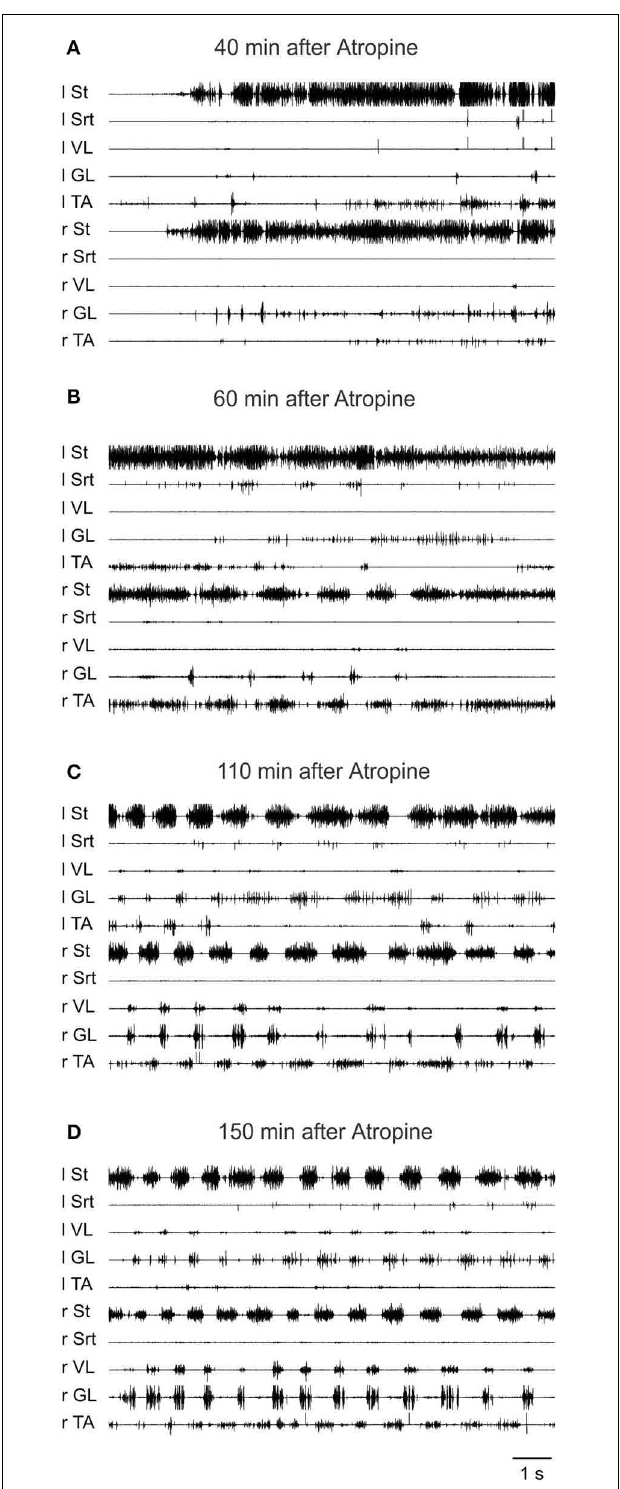
FIGURE 12 | The effect of a sub-threshold dose of clonidine is facilitated by atropine. Clonidine was first given i.v. (20 μ g/kg) and then atropine (1.5ml of a solution containing 1mg/ml of atropine) was given through a bath covering the L3-L4 segments of the spinal cord 40min later